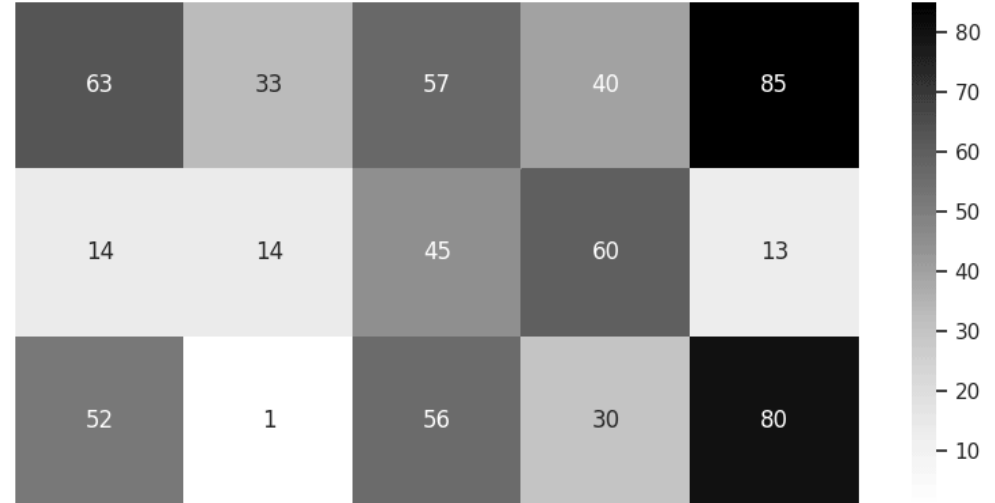
Figure 14. The heatmap of rest time (minutes) in nightly groupings.